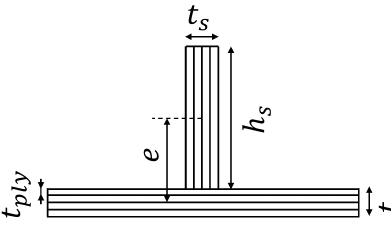
Figure 7. Cross-section of the